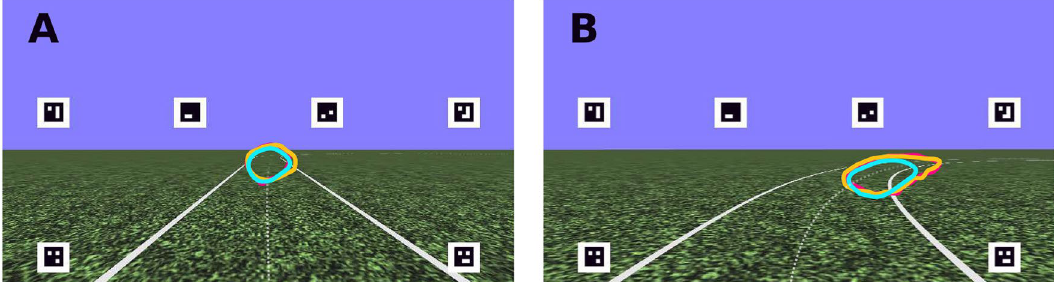
Figure 2. Screenshots. Screenshots of the straight ( A ) and bend ( B ) sections of the track, with gaze density rings superimposed to identify general regions of interest: the regions where 80% of gaze fell for Manual (cyan), Auto-Replay (yellow) and Auto-Stock (magenta) driving conditions. The track midline reference (dashed line) used for estimating gaze time headway (see Fig. 4) is the path equidistant to either road edge. The dashed midline was invisible during the